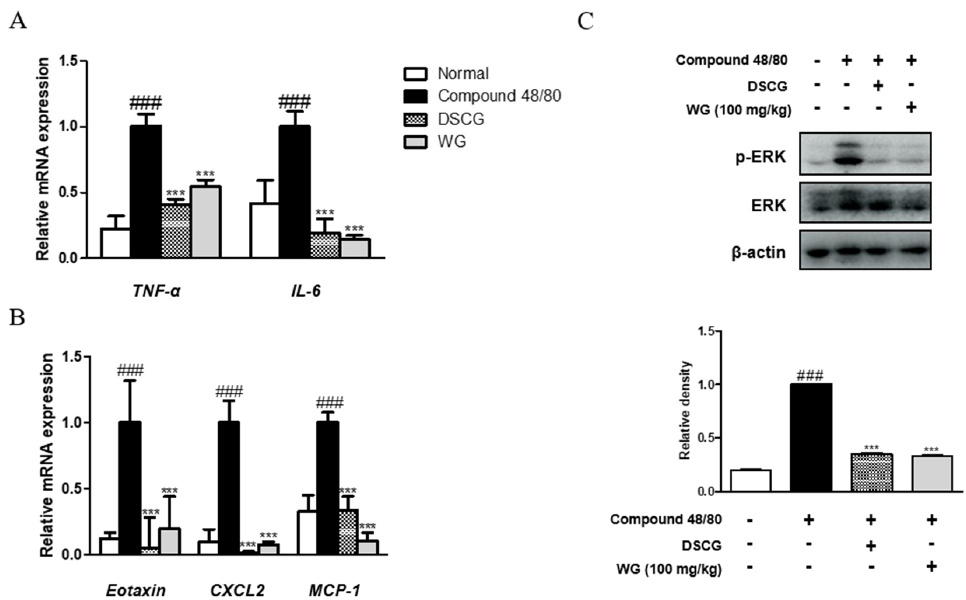
Figure 2. Effects of WG on compound-48/80-induced proinflammatory cytokines and ERK activation in a mouse model of anaphylactic shock. Total RNA prepared from the liver tissue and the mRNA levels of ( A ) TNF- α , IL-6, IL-1 β , ( B ) Eotaxin, MIP-2, and MCP-1 were determined by quantitative qRT-PCR. ( C ) Expression of ERK was determined by Western blot analysis using specific antibodies. Here, β -actin was used to normalize protein expression levels. Densitometric analysis was performed using Bio ‐ Rad Quantity One ® software. The data shown represent means ± S.D. of three independent experiments. Note: ### p < 0.001 vs. the control group; *** p < 0.001 vs. compound 48/80 ‐ treated group. DSCG; disodium cromoglycate.